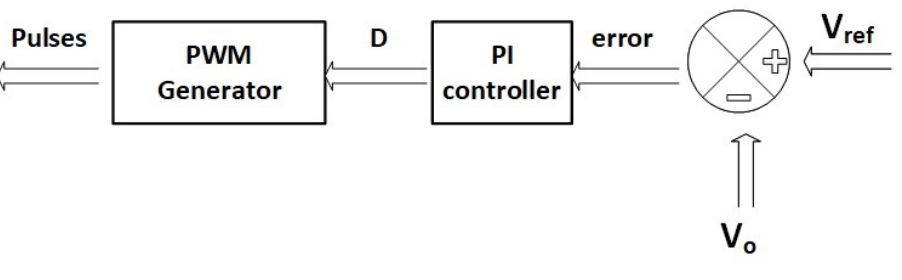
Figure 6. Schematic of the converter